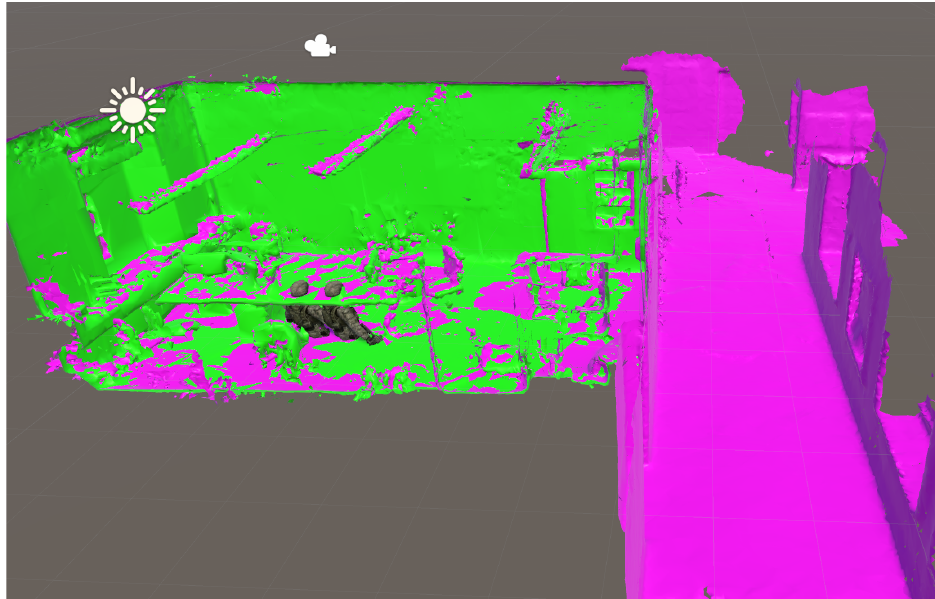
Figure 11. Map merging with UWB/visual (V)-SLAM-based relative pose